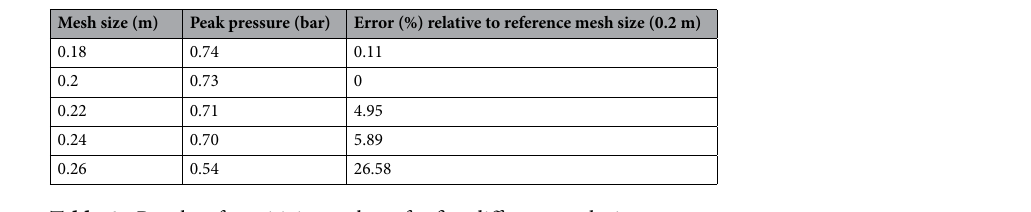
Table 6. Results of sensitivity analyses for five different mesh